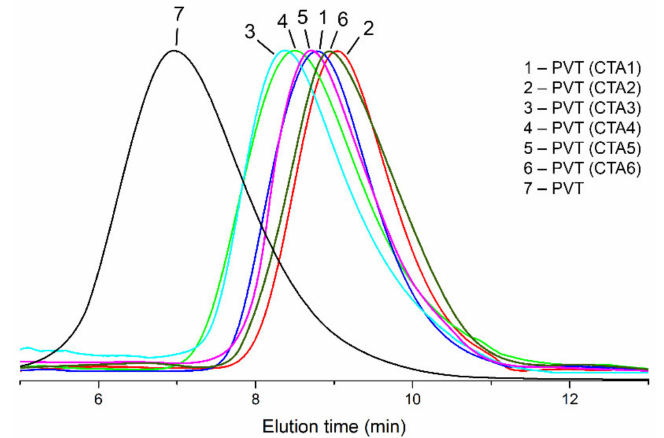
Figure 2. The GPC curves of PVT: 1–6—obtained by controlled radical polymerization in the presence of CTA1–CTA6; 7—obtained by free radical polymerization in